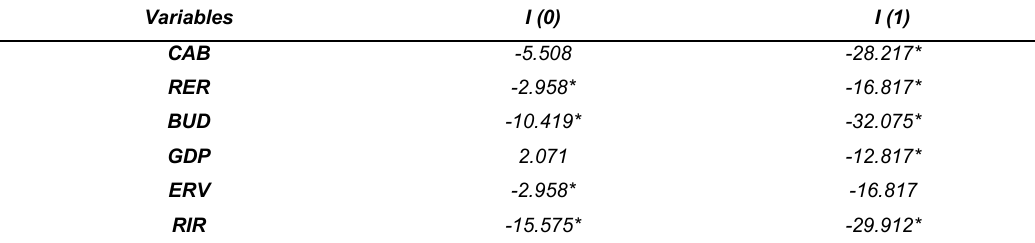
Table 2. Im, Pesaran & Shin unit root test.